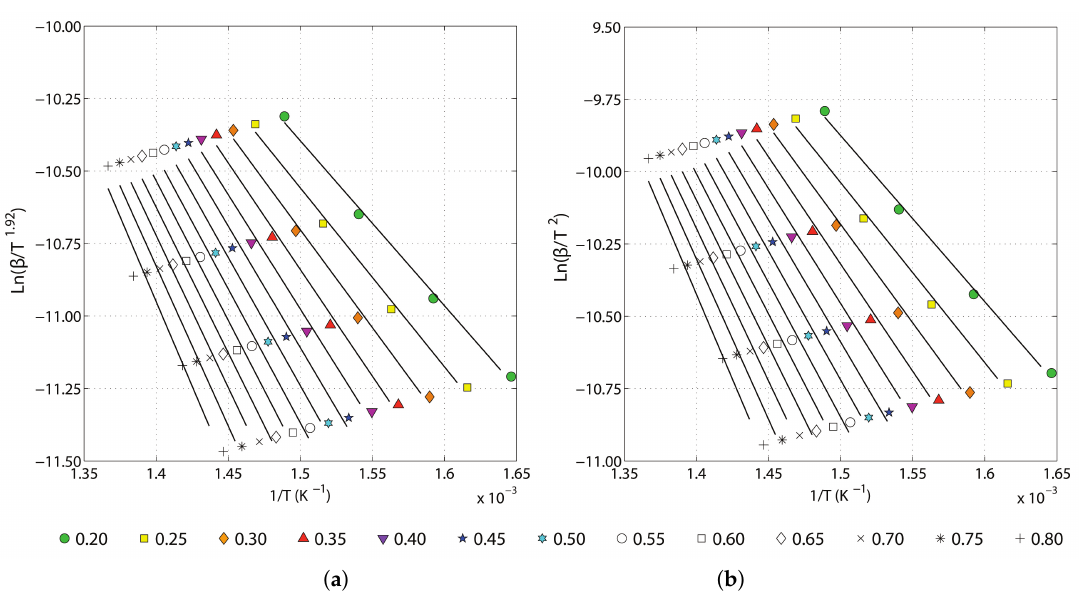
Figure 3. Plots for determination of activation energy at different conversion rates by ( a ) Starink method, and ( b ) Miura-Maki method. Table 3. Activation energies of animal fat at different degrees of conversion by using Starink and Miura-Maki